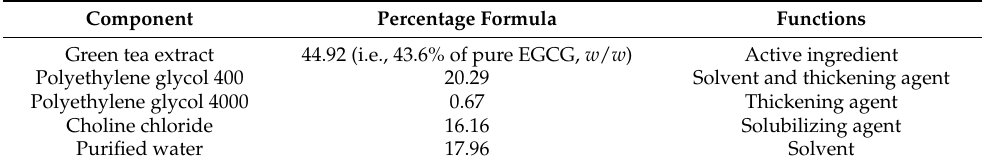
Table 1. Composition of the solution for capsule